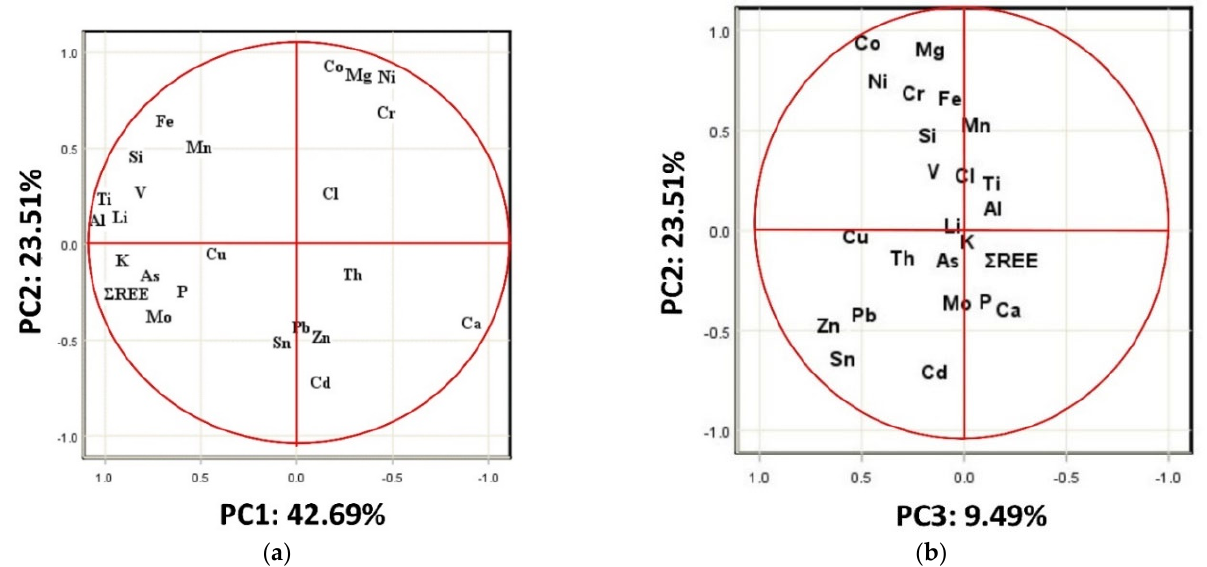
Figure 9. PCA loadings plots: ( a ) PC1 vs. PC2, ( b ) PC2 vs. PC3. Table 9. PCA factor loadings for elements in studied samples. The Co, Cr, Mg, and Ni displayed the highest positive loading on PC2. Their common grouping indicates their common anthropogenic source. Khudhur et al. [31] previously reported elevated Cr, Co and Ni levels in soils near a steel plant in Erbil, while Reck et al. [79] reported that Ni is mainly used in alloyed form in a steel plant. Mg is